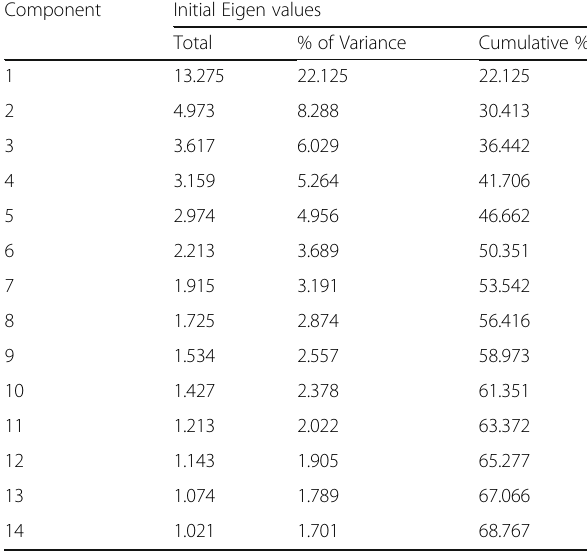
Table 5 Principle components and total variance Component